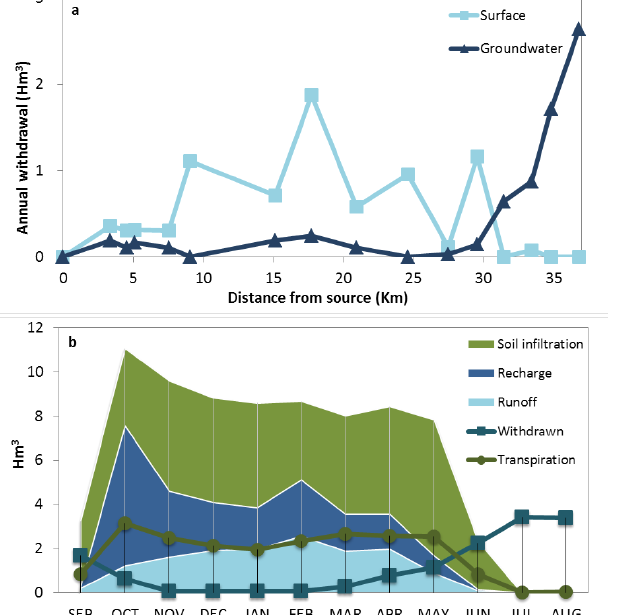
Fig. 8 . (a) Spatial distribution of water withdrawals; (b) Seasonal distribution of water funds and flows.